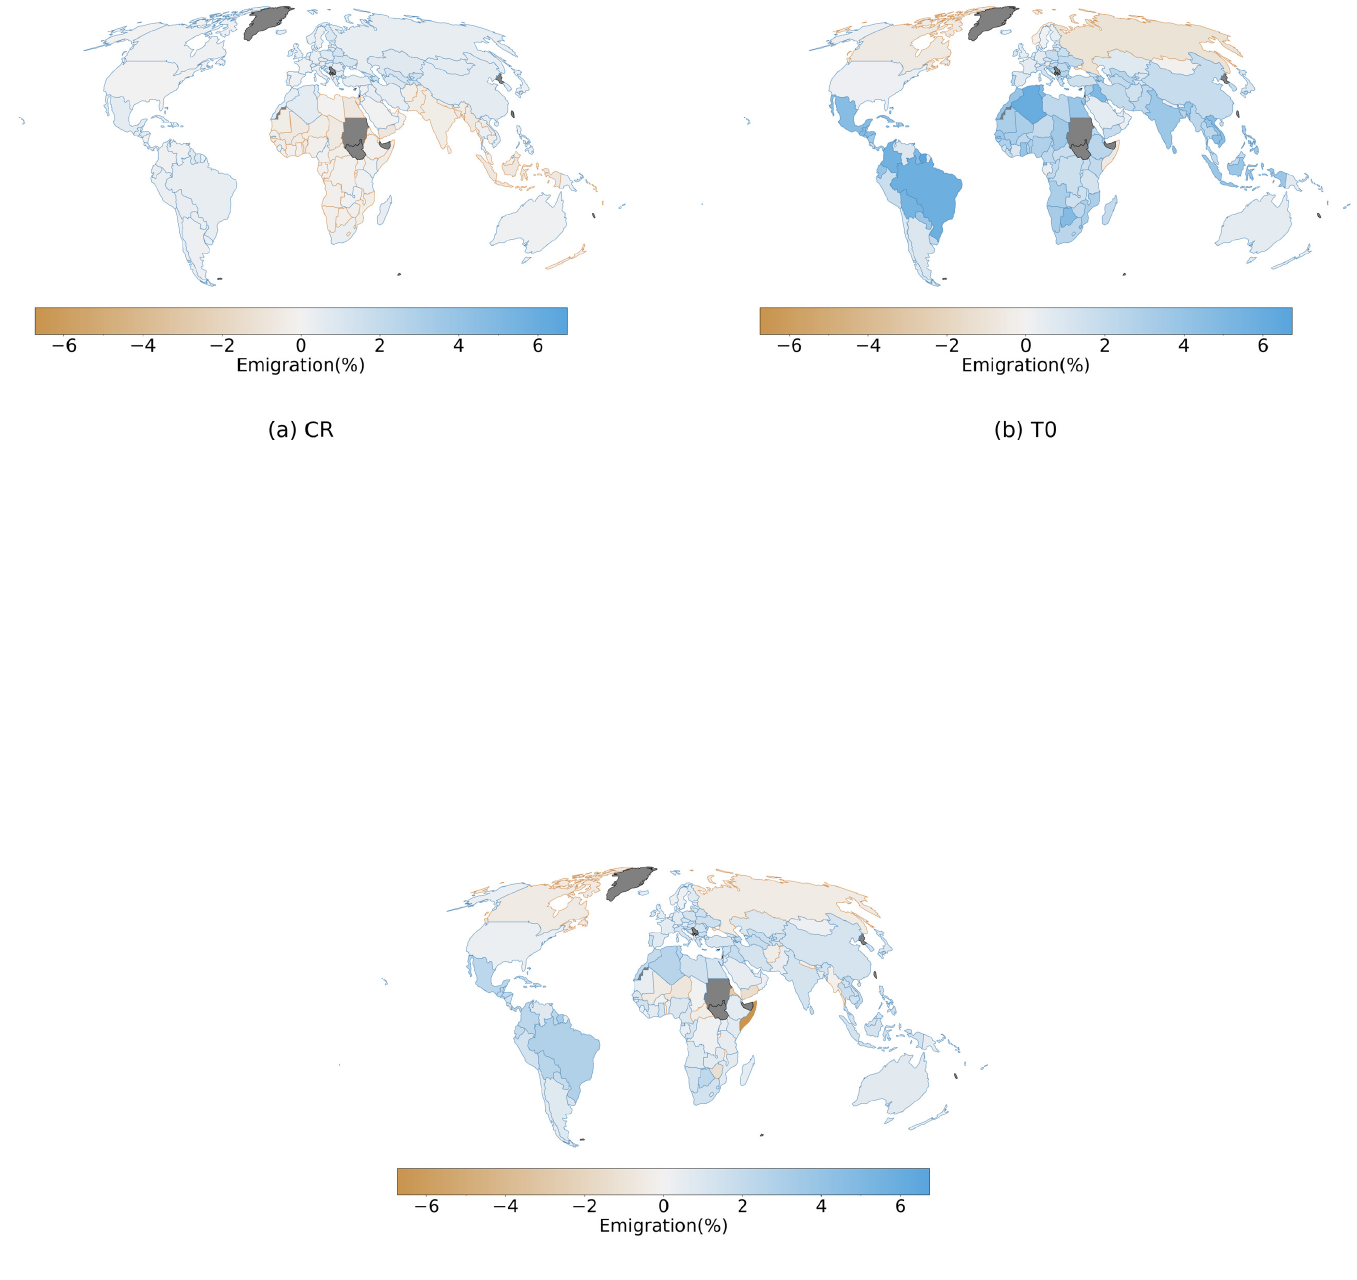
Fig 4. Country level, climate change impact on emigration under SSP5–8.5 scenario and short-term impact method for the three different assumptions regarding emigration rates. Positive values represent increase in emigration flows under the climate change impact case. The change is calculated as relative to a baseline scenario without climate change impact. Values represent the mean reached within the 30-years period of 3˚C global warming (see Methods), and are then averaged along the ensemble of GCMs. Panel (a) shows the change under the CR assumption, panel (b) covers the T0 assumption and panel (c) the TS assumption.